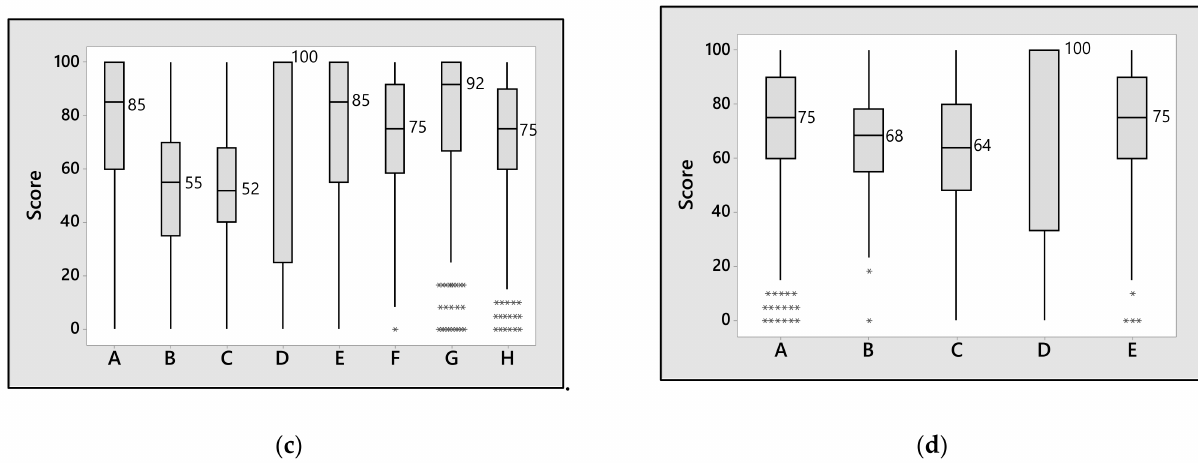
Figure 1. Overall QoL in MS patients. ( a ) Figure A shows the distribution of Physical Health Composite Score. ( b ) Figure b shows Mental Health Composite Score. ( c ) Figure C reports in box plots the subscales which contributes to Physical Health Composite Score calculation: A = Physical function, B = Health perceptions, C = Energy/fatigue, D = Role limitations–physical, E = Pain, F = Sexual function, G = Social function, H = Health distress. ( d ) Figure D illustrates the subscales composing the Mental Health Composite Score: A = Health distress, B = Overall quality of life, C = Emotional well-being, D = Role limitations–emotional, E = Cognitive function. Data falling outside the 1st and 3rd quartiles’ range are plotted as outliers of the data (*).